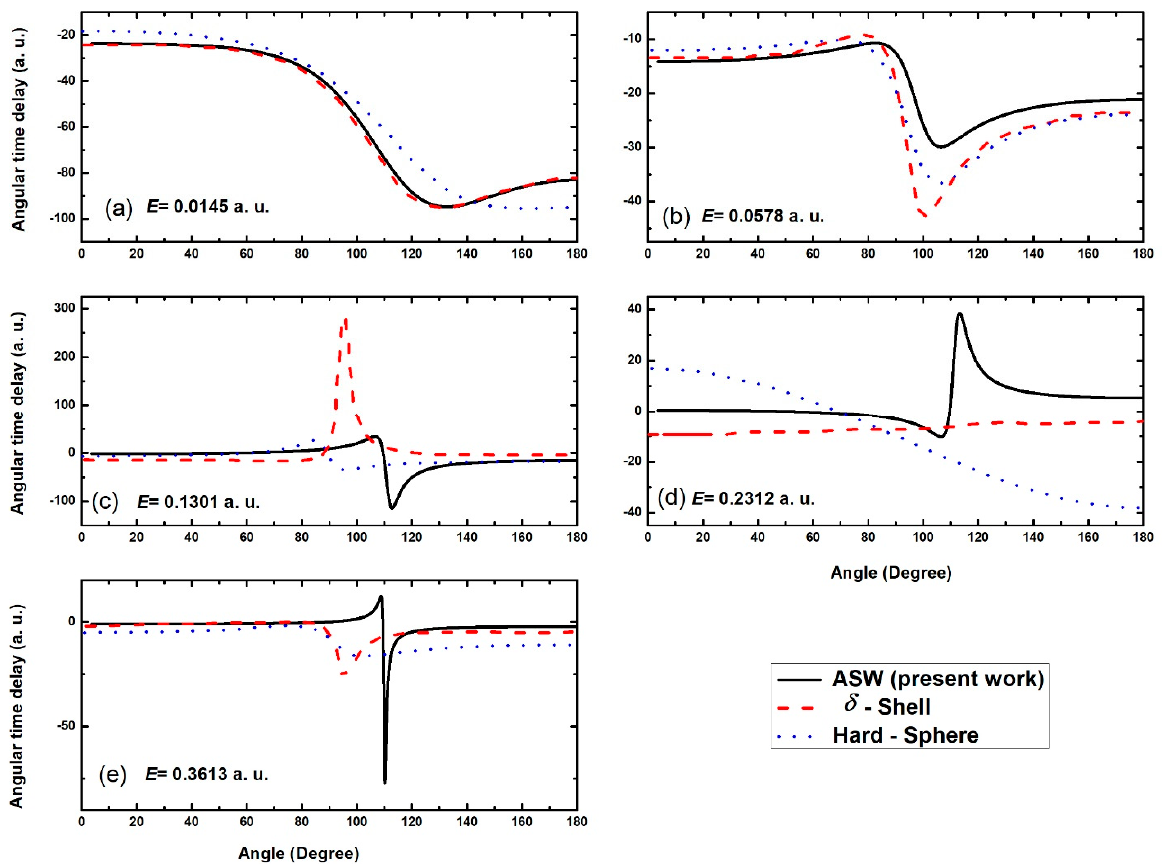
Figure 4. Comparison of angular time delay plotted for partial wave combination (cid:96) = 0,1 using ASW potential (solid black line), δ -shell (red dashed line) [50], and hard sphere (blue dotted line) [50] for energies ( a ) E = 0.0145 a.u., ( b ) E = 0.0578 a.u., ( c ) E = 0.1301 a.u., ( d ) E = 0.2312 a.u. and ( e ) E = 0.3613 a.u.